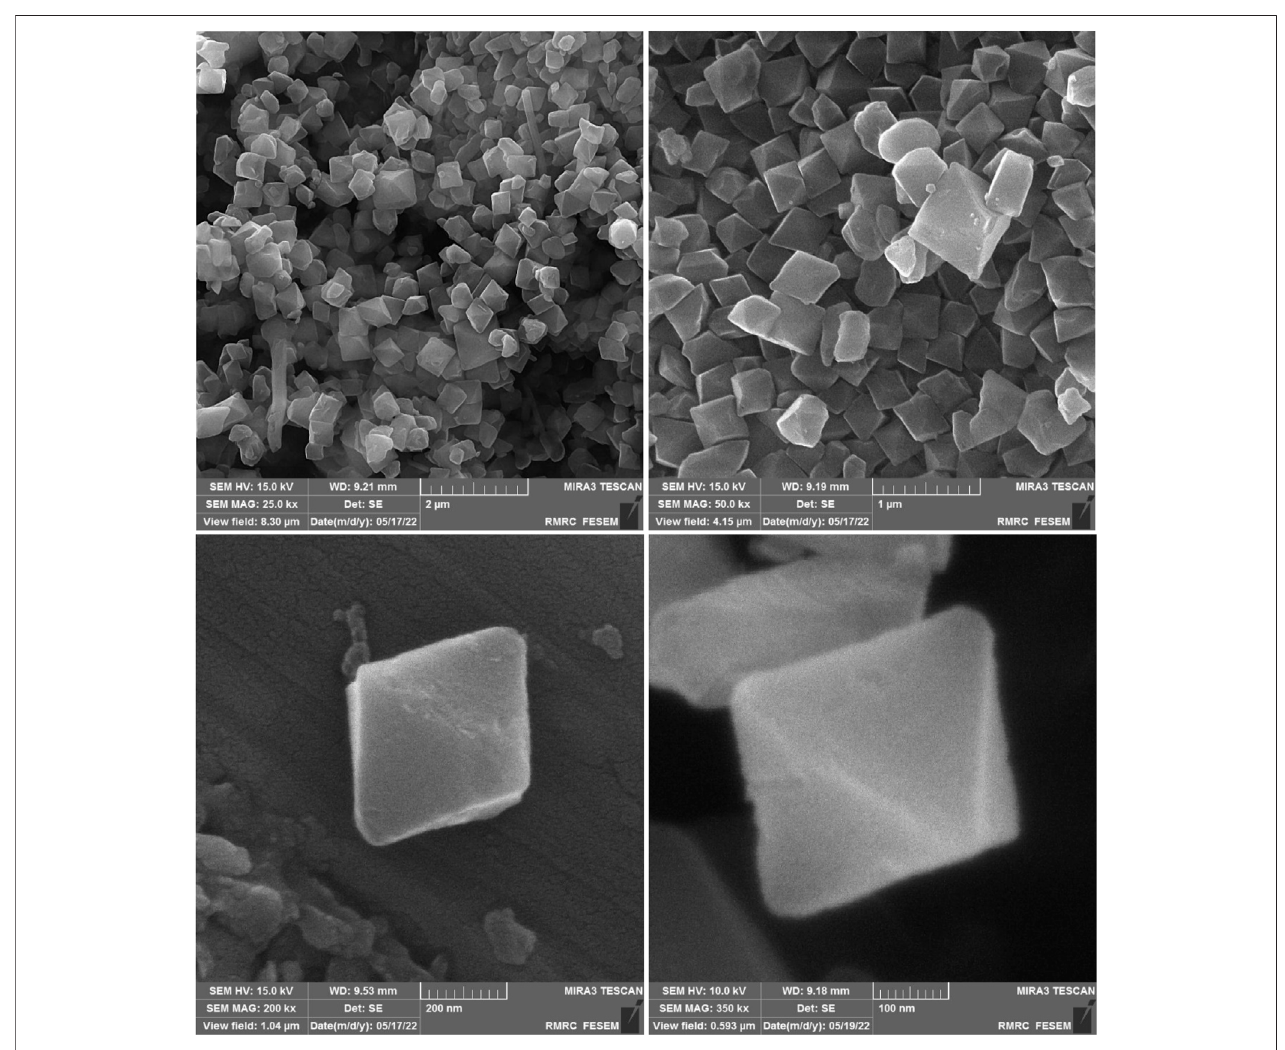
FIGURE 2 | SEM images of the MIL-101(Cr)